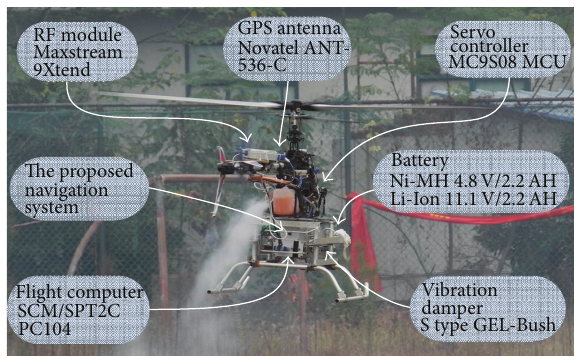
Figure 10: The miniature unmanned helicopter.